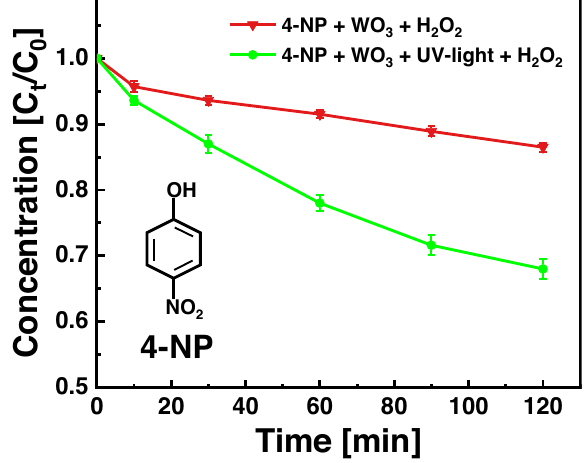
Fig. 4 Photocatalytic degradation of 4-NP using WO 3 micromo- tors under UV-light irradiation in 1% H 2 O 2 . Error bars represent the standard deviation, n = 3 independent